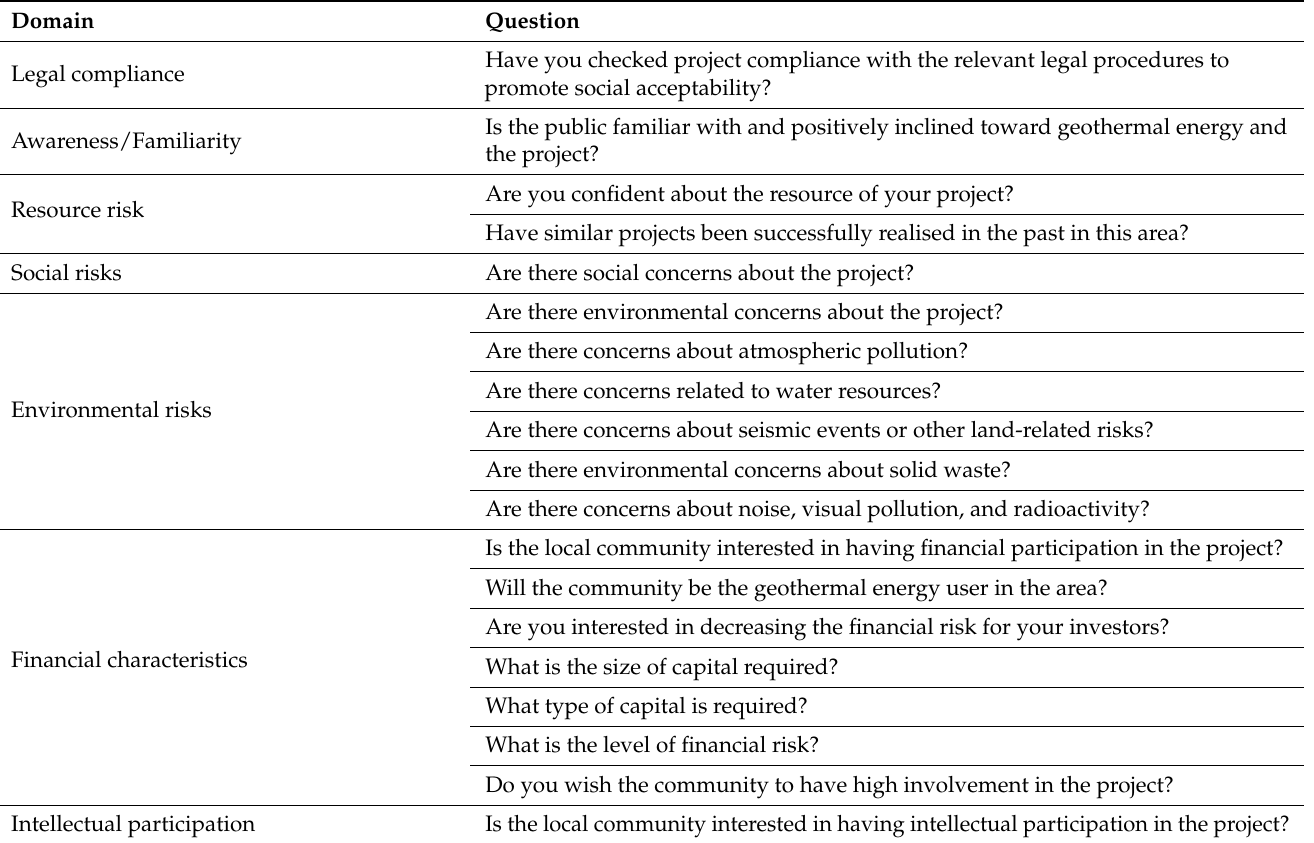
Table 1. DT questions (Source: based on